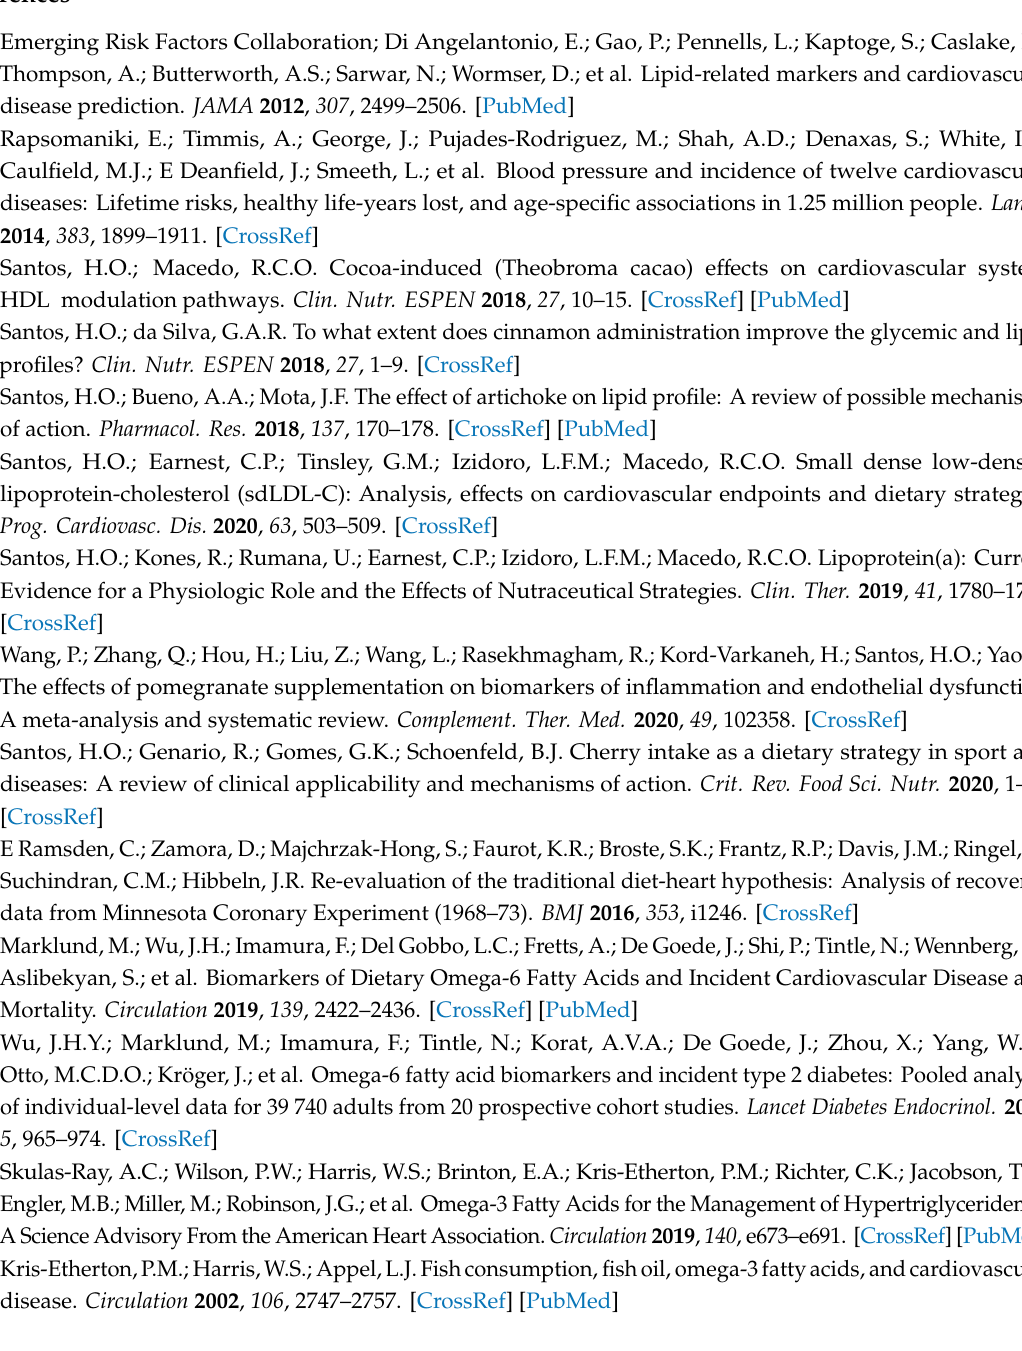
Table S1: Identification of RCTs that investigated the e ff ects of nuts and seeds rich in ALA through the database search, Table S2: Identification of RCTs that investigated the e ff ects of ALA-rich oils through the database search, Table S3: Identification of RCTs that investigated the e ff ects of seaweed through the database search, Table S4: Identification of recent RCTs that investigated the e ff ects of fish oil supplementation through the database